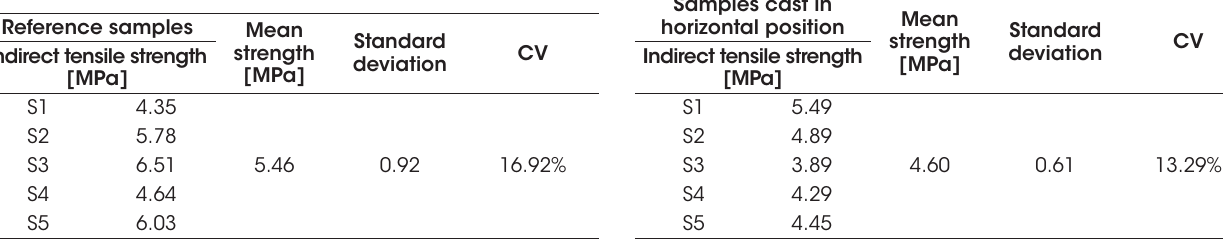
Indirect tensile strengths measured in samples